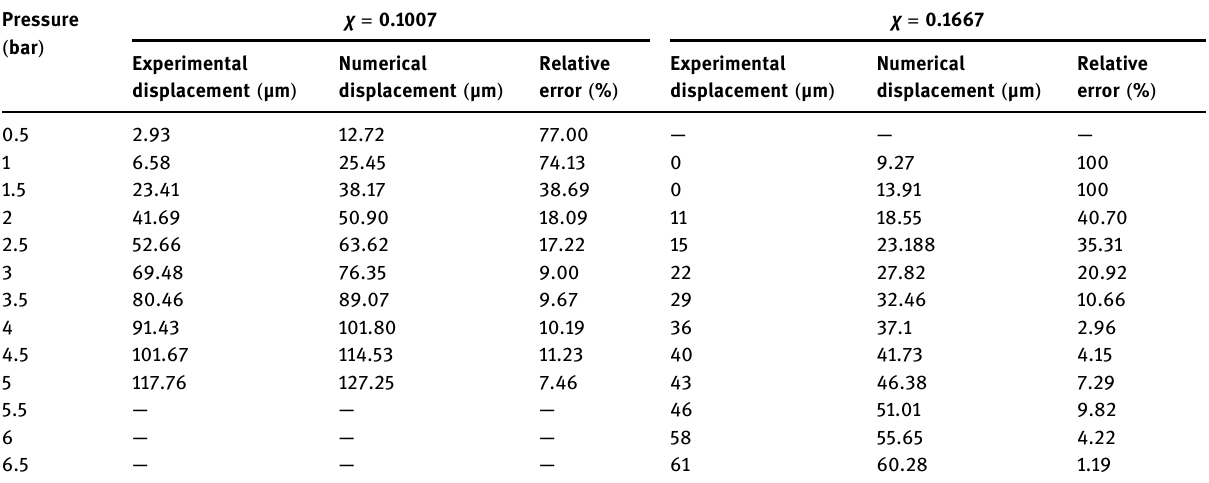
Table 3: Relative error between experimental results and numerical calculation for radial displacement investigation